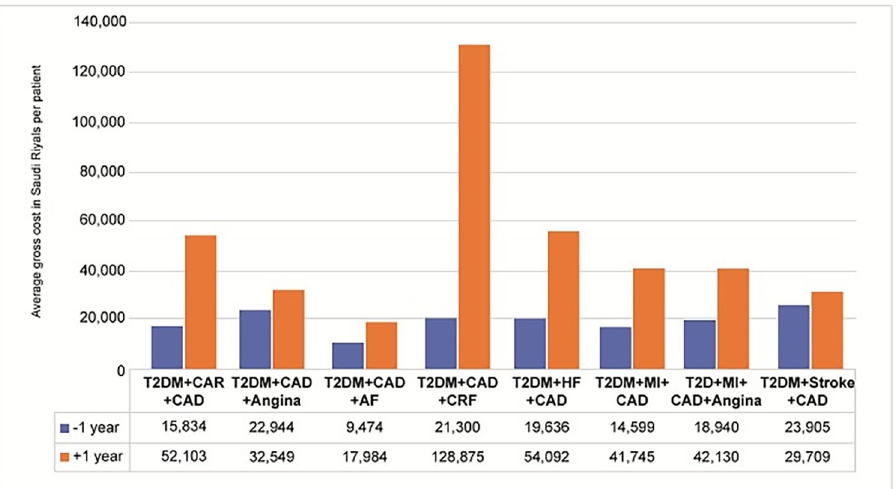
Fig 3. HCRU cost for inpatient claims for multiple CV and renal events during 1-year follow-up period (Payer 1, Cohort